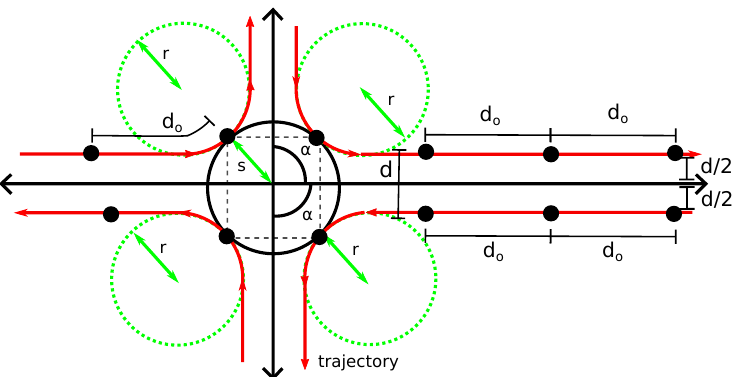
Figure 13. Theoretical trajectory in red, for α = π / 2 and K =